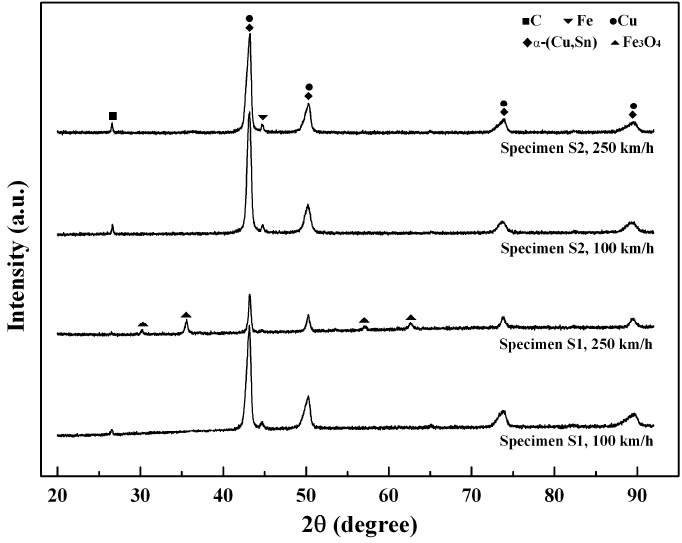
Figure 10. XRD analysis results of friction surfaces for two specimens at two speeds and 0.4 MPa.